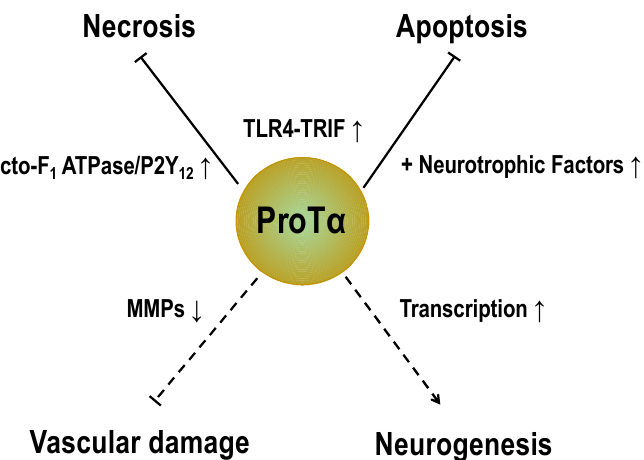
Figure 6. ProT α as a brain-protective molecule. ProT α plays multiple brain-protective roles against stroke. Upon the ischemic stress, nuclear protein ProT α is extracellularly released and suppresses necrotic mechanisms, potentially through the ecto-F 1 ATPase-P2Y 12 complex, which is coupled to G i -mediated mechanisms. Extracellular ProT α also leads to apoptotic mechanisms via apoptosome- caspase 3 pathways, which delay the occurrence of necrosis. During this period, NTFs, such as BDNF, are produced and inhibit apoptosis. ProT α also inhibits the activation of MMPs and protects the brain from vascular damage. A study using ProT α +/ − mice found that ProT α plays key roles in adult neurogenesis under naïve and ischemia conditions. All of these findings suggest that ProT α plays brain ‐ protective roles.